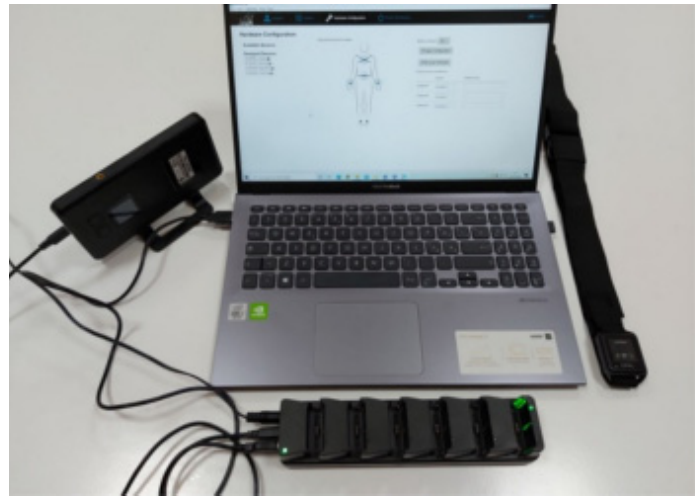
Figure 1. Mobility Lab System: access point, docking station, movement monitor, Mobility Lab software.